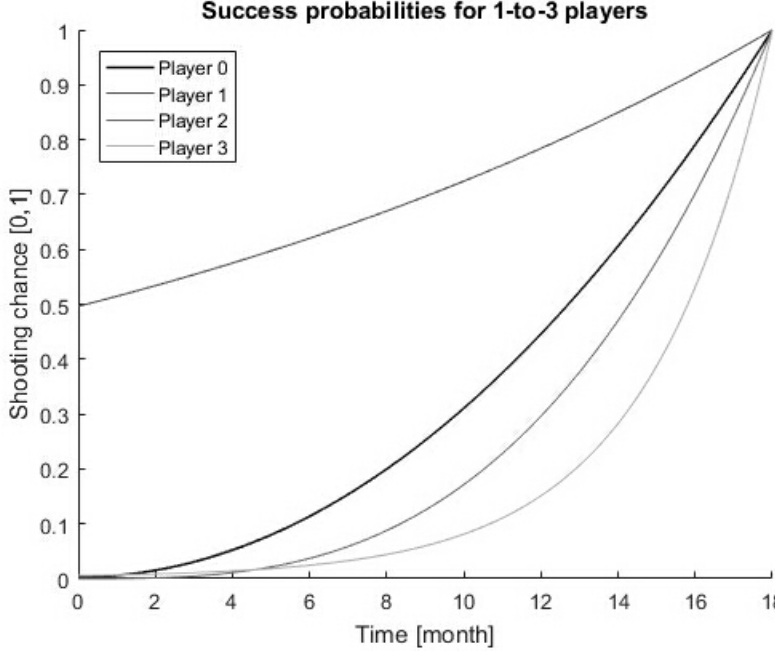
Figure 1. Success probabilities for 1-to-3 duel games (4-person